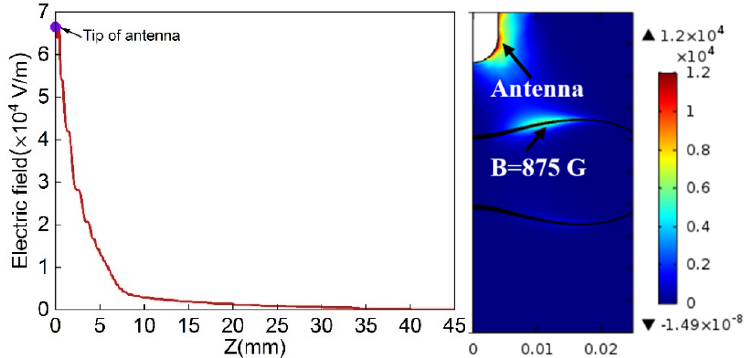
Figure 10. Simulated normal RF electric field strength along the axial direction, and RF power